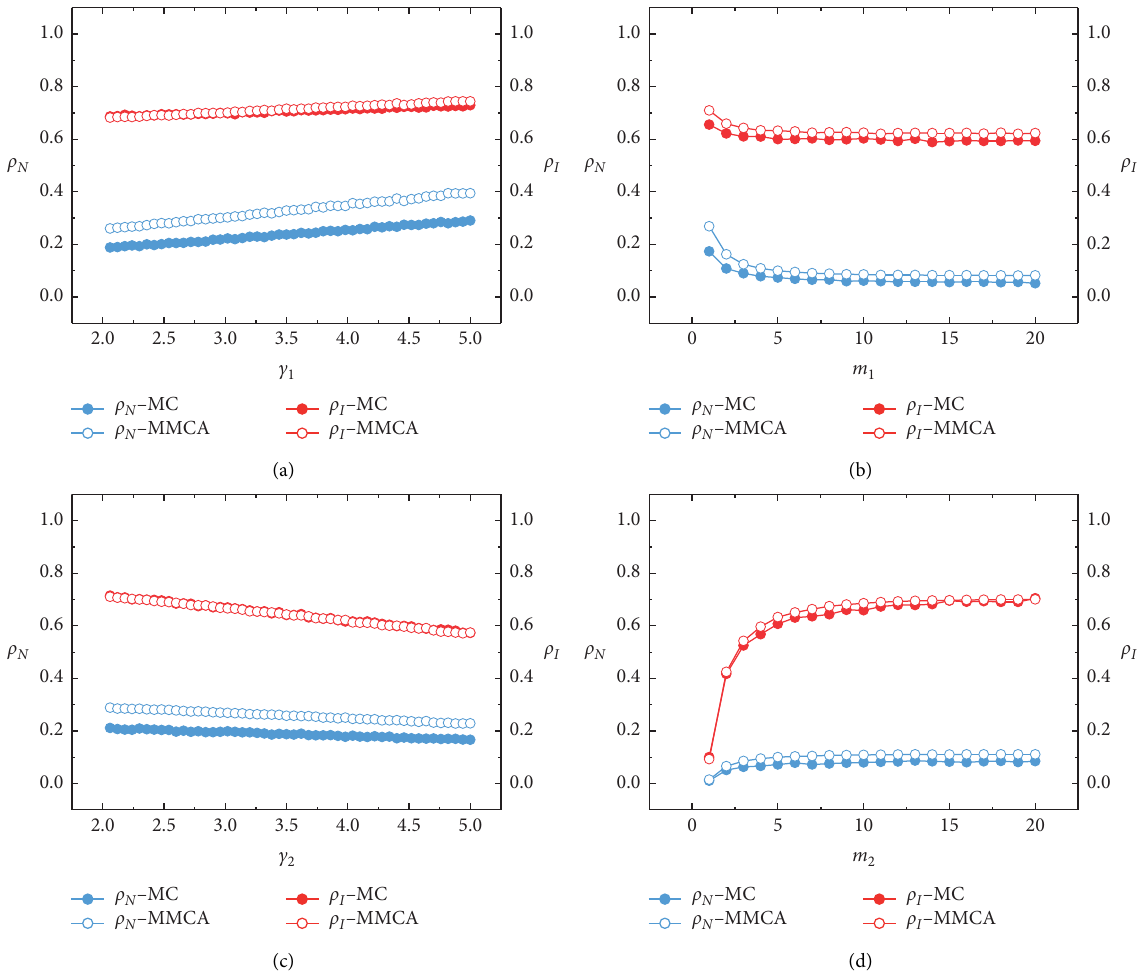
c i and the contact (a) and m (b) in the 1 1 (a) and m (b) in the 2 2 � 5 for (a), (c), and (d); m � 5 for 1 2